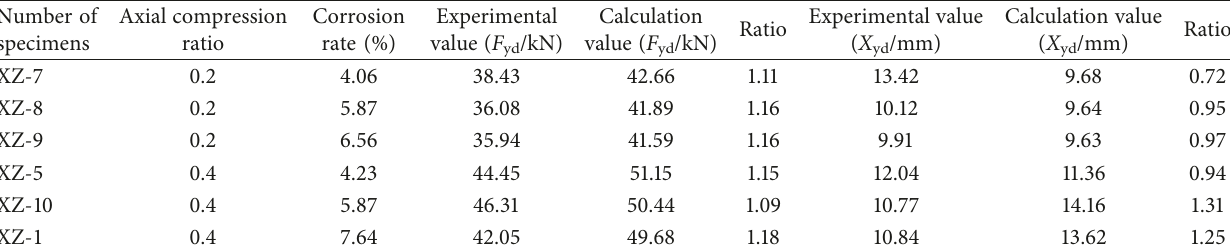
Table 7: The comparison between theoretical value and experimental value.